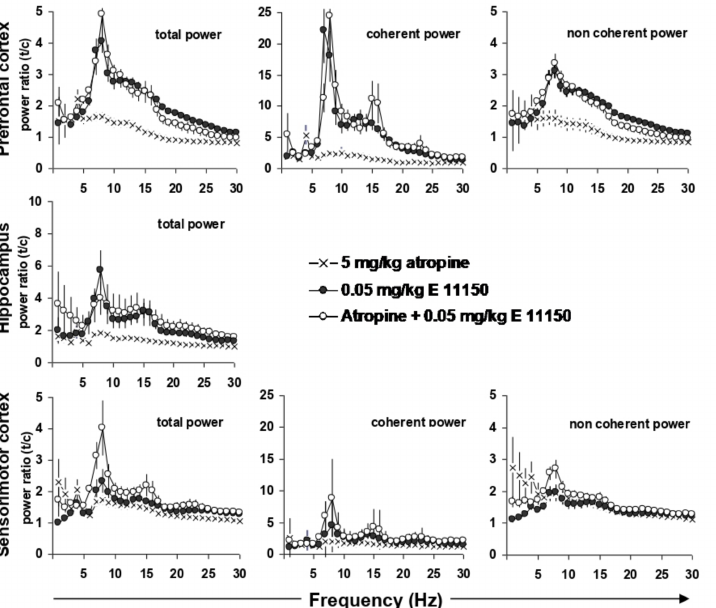
Figure 5. Effects of EGIS-11150 on EEG power in prefrontal cortex, in hippocampus and on hip- pocampal to prefrontal cortex coherence. Note the marked increase in hippocampal-prefrontal cortex coherence. Atropine (5 mg/kg i.p.) did not modify the effects of EGIS 11150 (0.05 mg/kg) indicating that the effects of EGIS 11150 on theta were presumably not of cholinergic origin; note however, that there was a small increase at 4 Hz in the presence of EGIS 11150 and atropine. Effects on sensorimotor cortex were considerably less marked. The 95% confidence interval corresponds to the error bars in each figure, n =